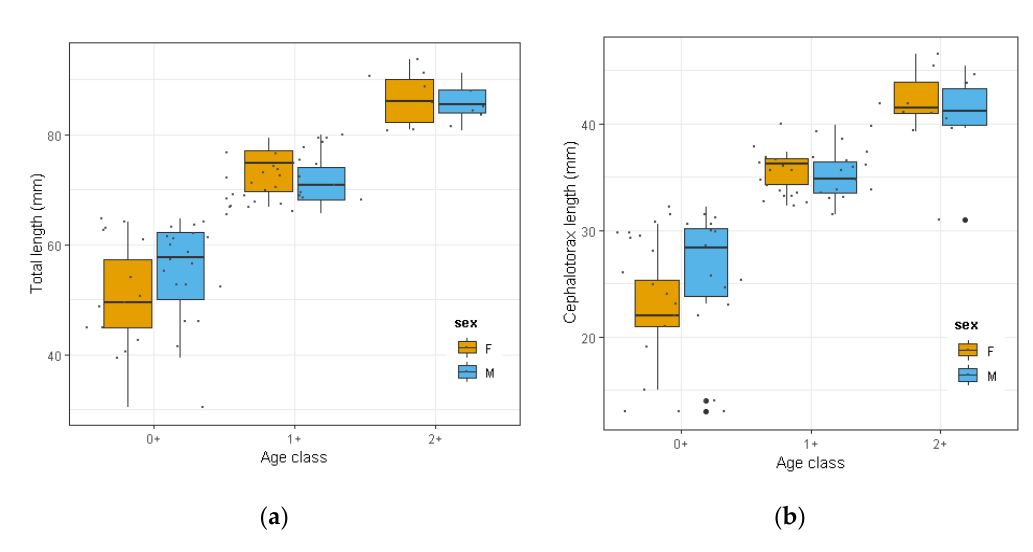
Table 2. Body size measures. Distribution range (minimum, maximum, mean, and standard deviation values) for the main biometric features for Orconectes limosus . Wtot: n = 227, Ltot and Lcft: n = 238.